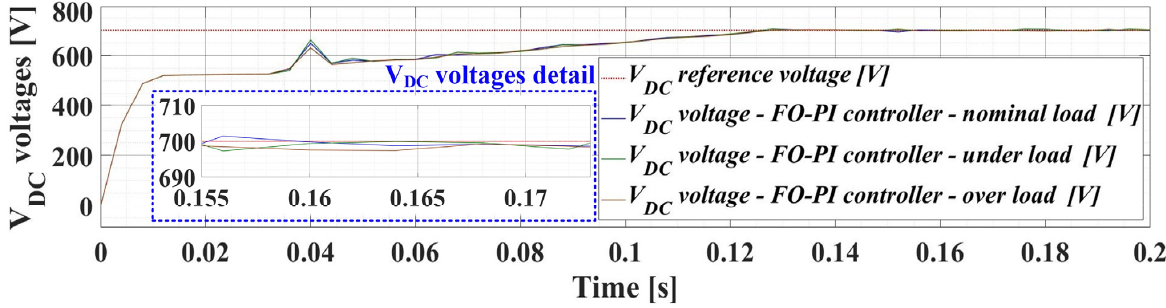
Figure 10. V DC voltages time evolution of the UPQC-APF control system based on FO-PI controller in case of nonlinear load.